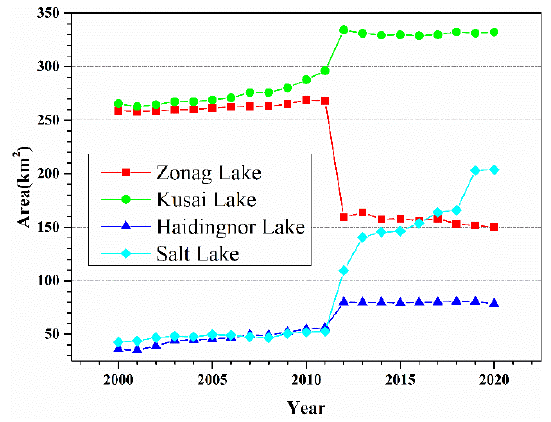
Figure 5. Areas of four lakes in ZSLB between 2000 and 2020.